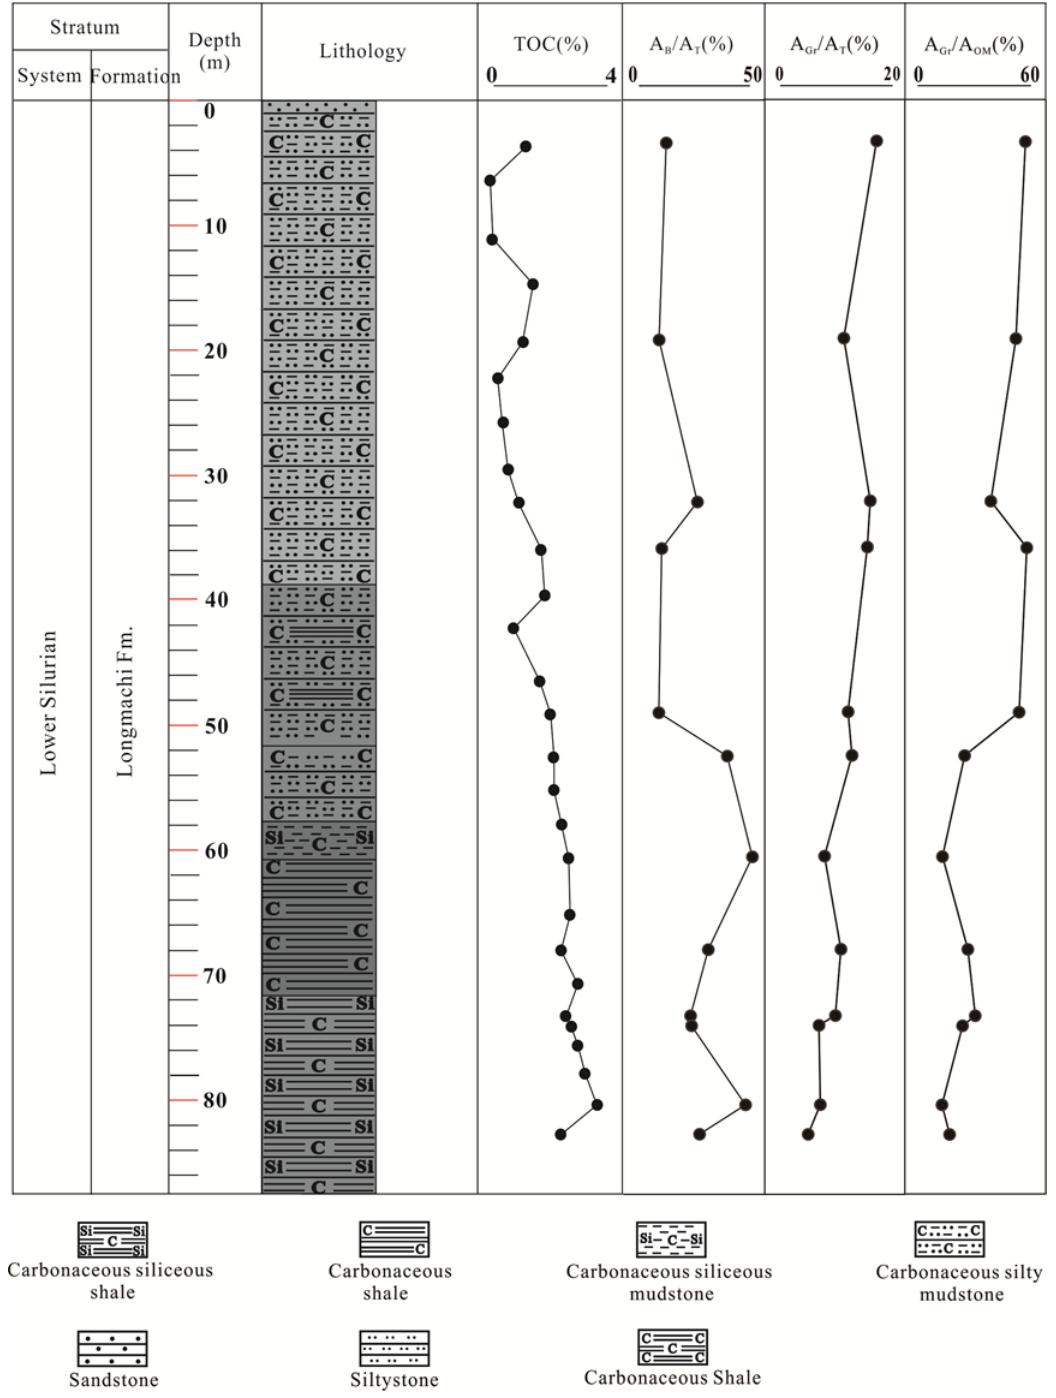
Figure 2. Stratigraphic columns of the Longmaxi Formation from the Xikeng section in southeastern Hubei Province, China. A B /A T : absolute values of bitumen area/total horizon area; A Gr /A T : graptolite area/total horizon area; A Gr /A OM : graptolite area/organic matter area.